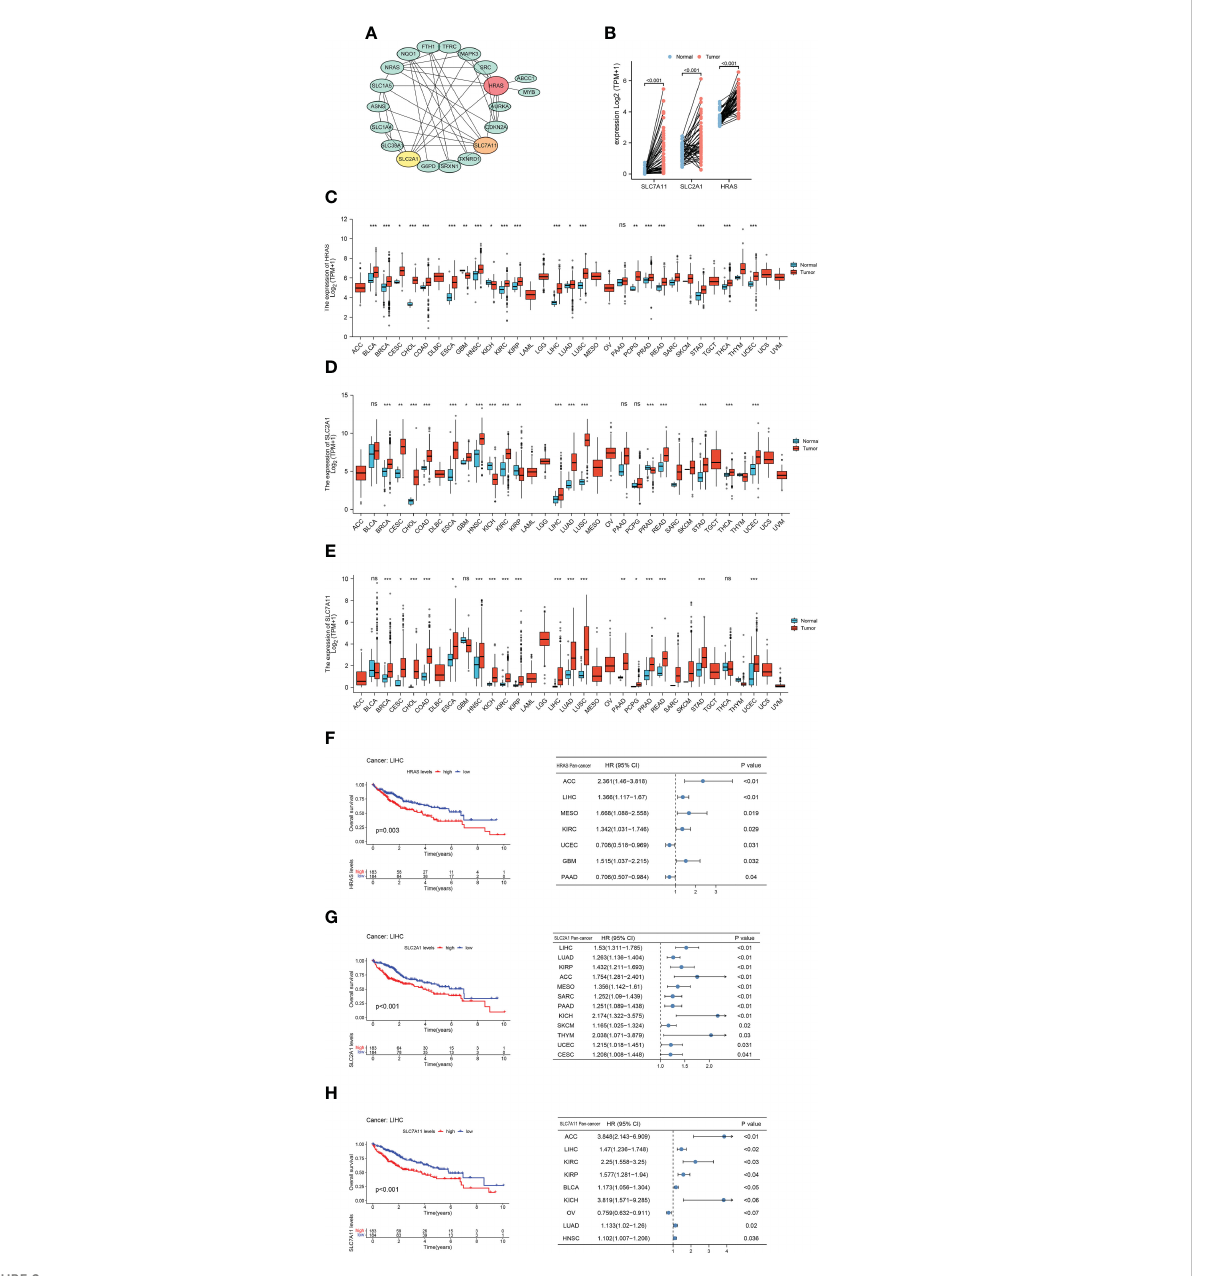
p53 signaling pathway, T cell receptor signaling pathway, adherens junction, mTOR signaling pathway, Oocyte meiosis, ubiquitin- mediated proteolysis, cell cycle, and DNA damage repair. Therefore, it is reasonable to speculate that cluster B may be associated with invasive HCC, while cluster A may be associated